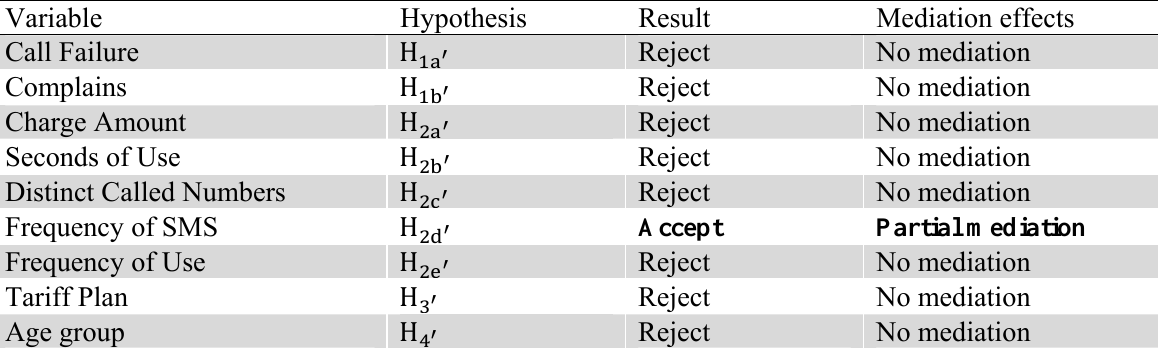
The results of intermediate hypotheses